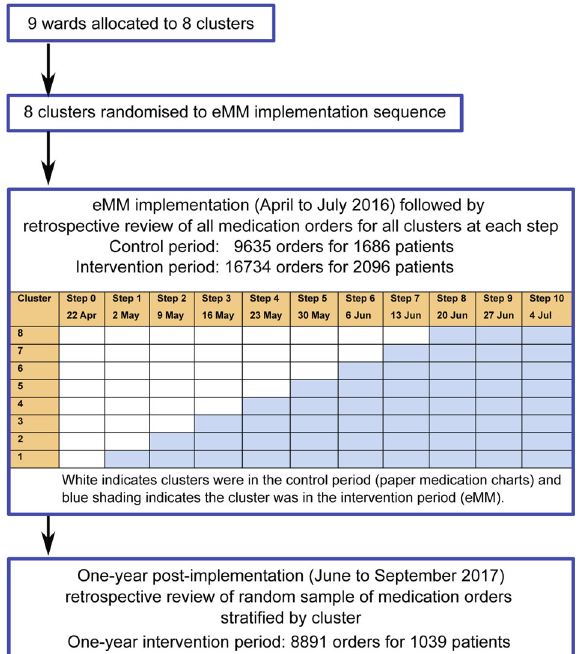
Fig. 1 Flow diagram of stepped-wedge cluster randomised con- trolled trial and one-year follow-up with retrospective collection of prescribing